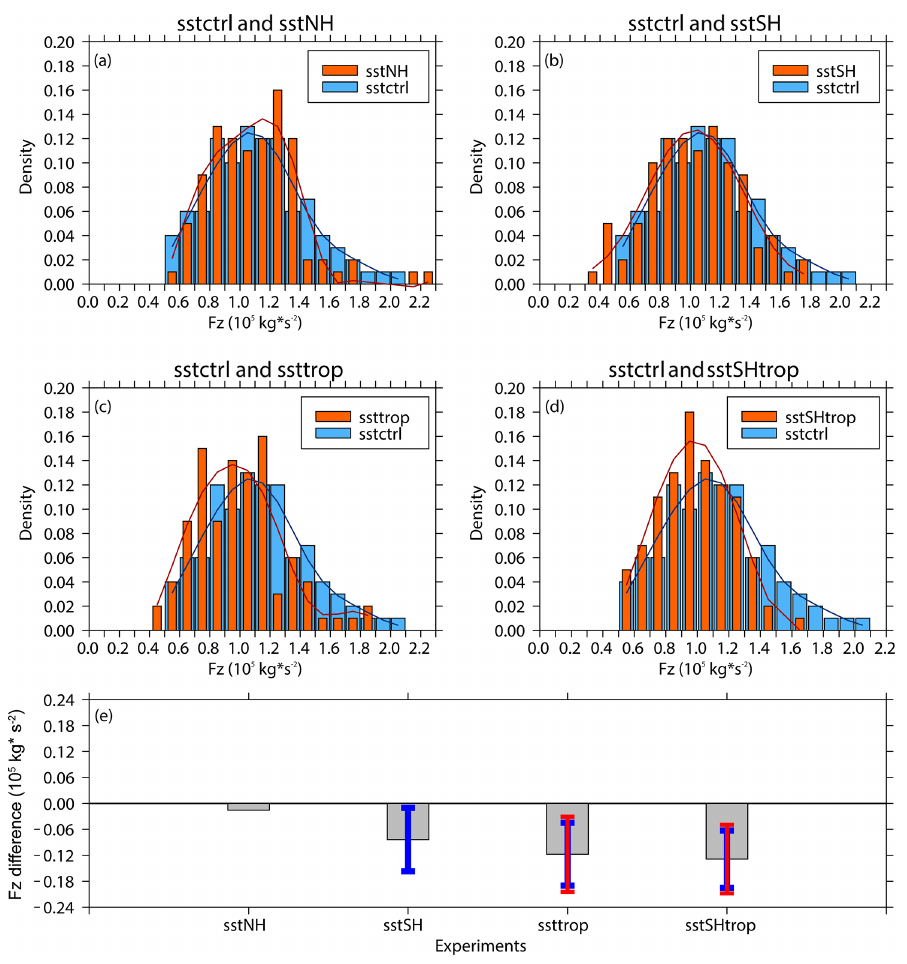
Figure 14. (a, b, c, d) Frequency distributions (pillars; blue for the control experiment and orange for sensitivity experiments) of vertical E–P flux (Fz; area weighted from 200 to 10hPa over 70–50 ◦ S) and its five-point low-pass filtered fitting curves (solid lines; blue for the control experiment and red for sensitivity experiments) derived from 100 ensemble members of the control experiment (sstctrl) and sensitivity experiments ( a sstNH; b sstSH; c ssttrop; d sstSHtrop), respectively. (e) Mean differences (gray pillars) and corresponding uncertainties (error bars) of Fz between sensitivity experiments and the control experiment. The blue and red error bars reflect the 90% and 95% confidence levels calculated by two-tailed t test, respectively. The error bar is omitted when the significance of mean difference is lower than the corresponding confidence